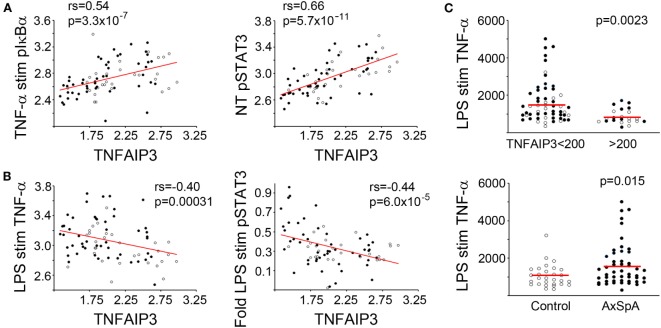
Functional correlations with tumor necrosis factor alpha-induced protein 3 (TNFAIP3) levels. Blood-derived macrophages were stimulated with media (no treatment or NT), TNF-α, or lipopolysaccharide (LPS). For biochemical signaling studies, cells were lysed after 30 min of stimulation and amount of phosphorylated signaling molecule determined by Luminex assay. For cytokine determination, cells were stimulated for 24 h and supernatant levels of TNF-α quantified using ELISA. Cytokine production and phosphorylated molecules were normalized by total protein. Pairwise correlations (Spearman’s correlation coefficient) between TNFAIP3 levels and signaling/cytokine output and corresponding p-values were determined (see Table 2). Axial spondyloarthritis (AxSpA) subjects are depicted with filled black circles and controls with open circles. In panels (A,B), red lines show correlations for log-transformed data. (A) Positive correlations with TNFAIP3 levels. (B) Negative correlations with TNFAIP3 levels. In panel (C), red lines denote mean TNF-α production in each group. LPS-induced TNF-α production separated by TNFAIP3 level (top, p = 0.0023) or spondyloarthritis status (bottom, p = 0.015) with p-values from a T-test statistic with 1 M permutations.